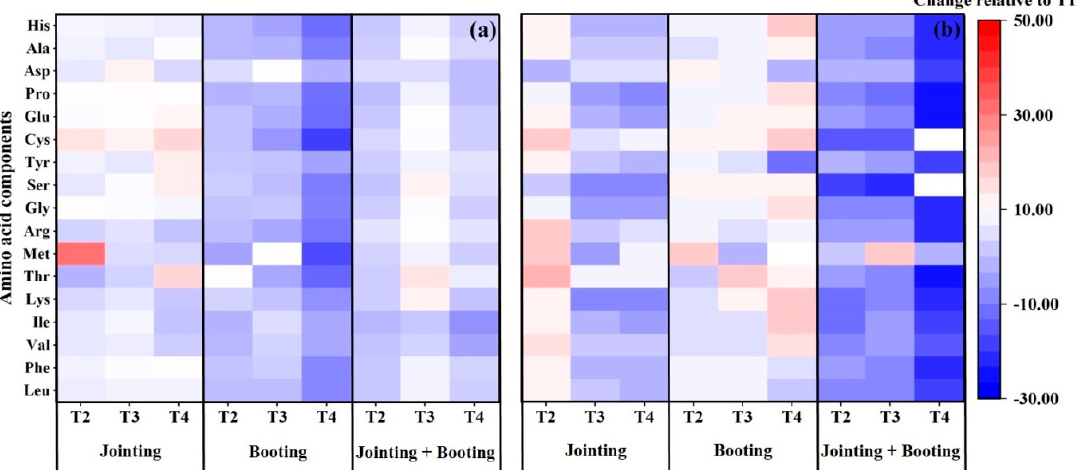
Figure 5. The relative contents of amino acid compositions of Yangmai16 ( a ) and Xumai30 ( b ) under different low ‐ temperature treatments.